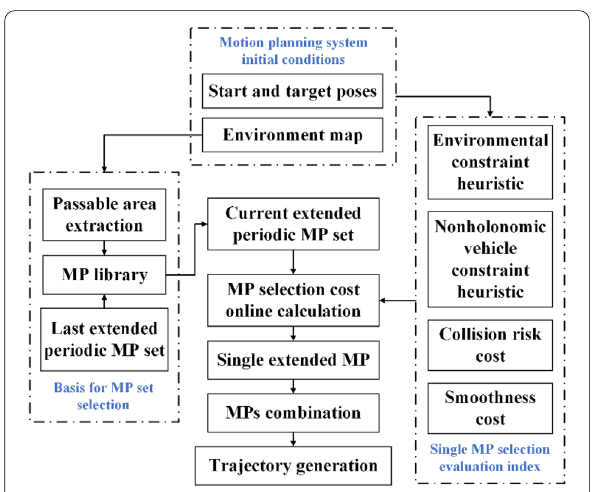
Figure 6 MP online selection algorithm